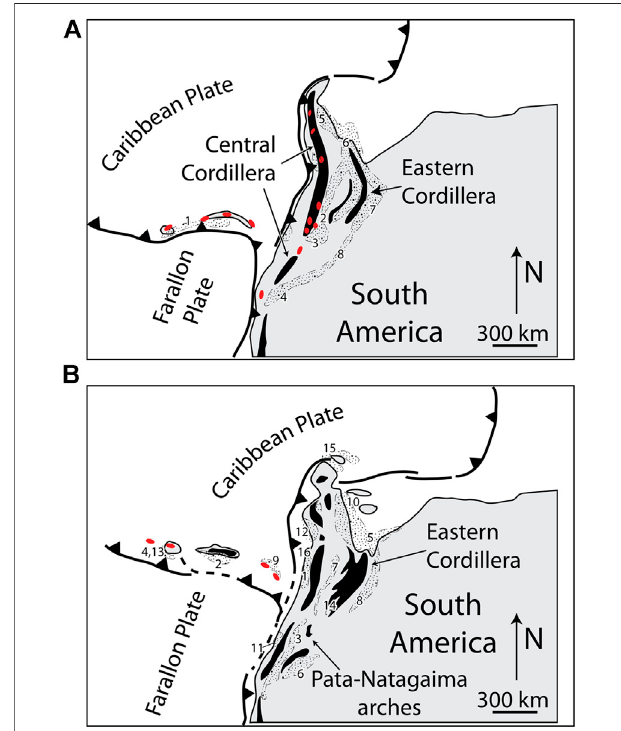
FIGURE 2 | Palinspastic reconstruction of the Northern Andes and southern Caribbean modi fi ed after Montes et al. (2019) showing signi fi cant relief in black, magmatic centers in red, and coarse-grained deposits (stippled pattern),trackingthepresenceandapproximatelocationofrelief,butnot its magnitude. Numbers represent the location of known clastic units of that age. (A) Schematic paleogeography of late Paleocene-early Eocene times (1: Woodring,1957;2:Guerreroetal.,2000;3:Montesetal.,2003;4:Ruizet al., 2004; Martin-Gombojav and Winkler, 2008; 5: Bayona et al., 2011; 6: